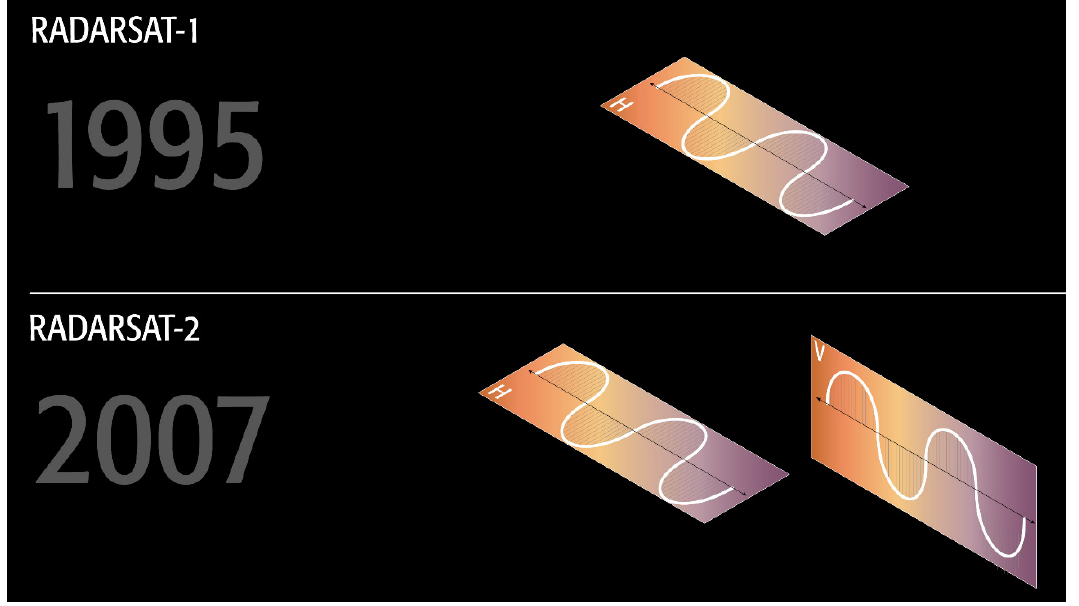
Figure 1. A comparison of how RADARSAT-1 and RADARSAT-2 transmit and receive radar waves. RADARSAT-1 transmits and receives radar waves horizontally to the target on the ground. RADARSAT-2 can transmit and receive radar waves in both the horizontal and vertical polarization plains, allowing calculation of the phase. Reproduced by permission of/or Courtesy of MacDonald, Dettwiler and Associates